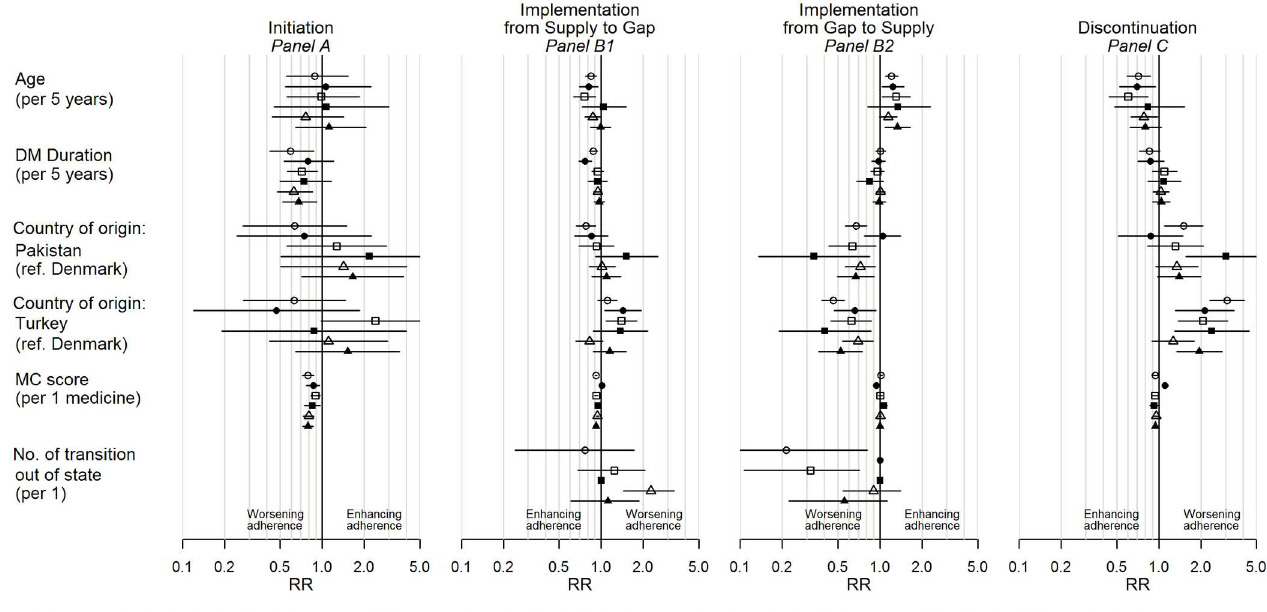
Fig 2. Rate-ratios for incidence of events of adherence to medication. Rate-ratios for Age (per 5 years), Diabetesduration(per 5 years), Country of origin with Denmarkas reference, MedicationComplexity score (per 1 unit), and Number of transitions out of state (per 1 transition). Panel A: For first initiationof treatment. For implementation: Panel B1: For runningout of supply into a supply gap; Panel B2: For resumingsupply of medicineafter a supply gap. Panel C: For first discontinuation of treatment. Panels A–D show rate-ratios for metformin, sulfonylureas, acetylsalicylicacid, thiazidediuretics, ACEs & ARBs, and statins. DM, DiabetesMellitus. MC score, MedicationComplexityscore. ACEs, AngiotensinConvertingEnzyme inhibitors. ARBs, AngiotensinReceptor Blockers.